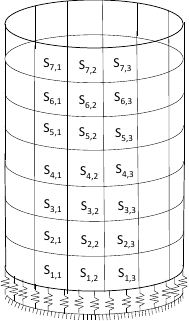
Figure 21. FE model of waterproof rubber.